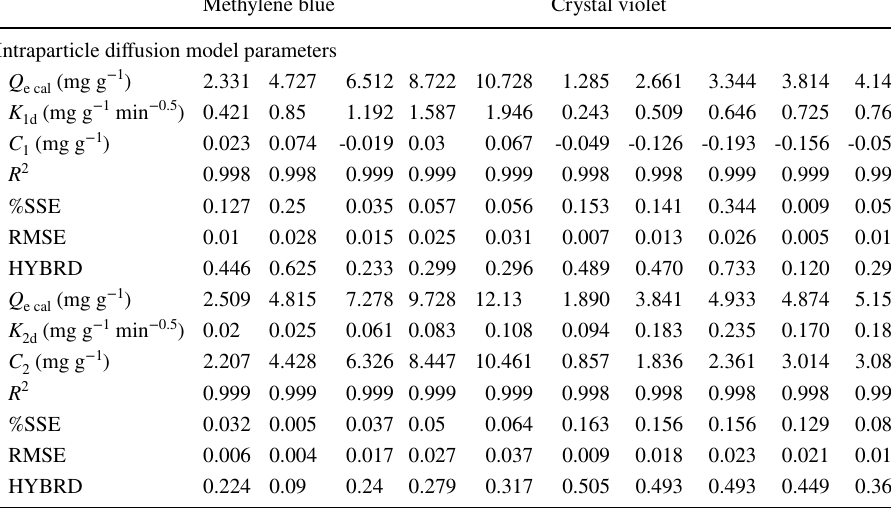
Methylene blue Crystal violet Intraparticle diffusion model